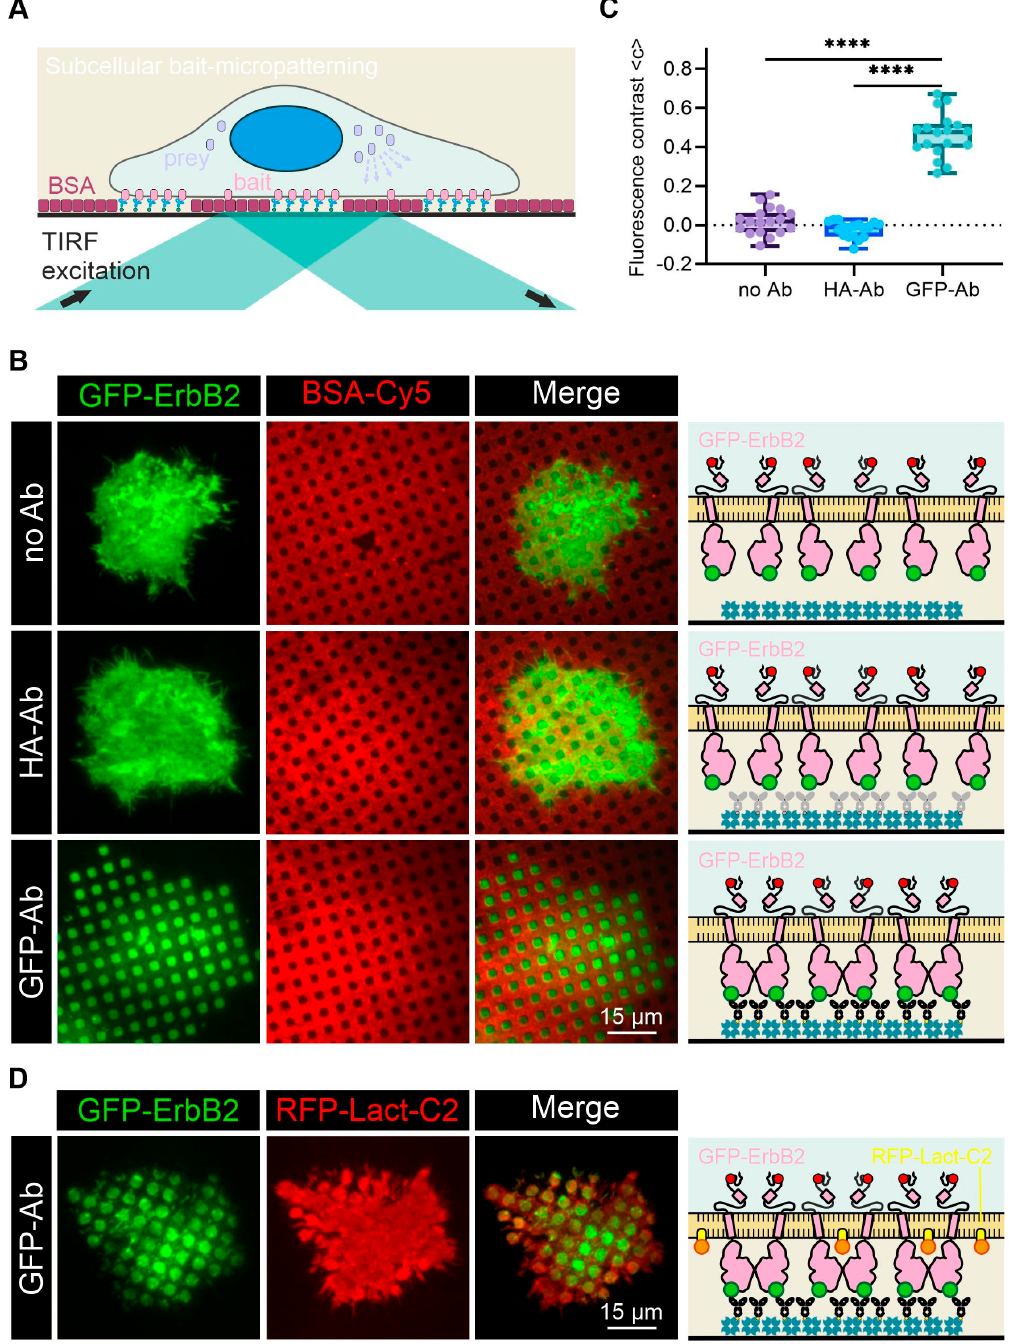
Figure 3. Applicability for subcellular micropatterning experiments. ( A ) Schematic presentation of the subcellular micropatterning assay. Cells are transiently cotransfected with fluorescently labeled bait (and prey) molecules and grown on antibody-patterned surfaces. Upon specific antibody–bait interactions, bait proteins are rearranged in the plasma membrane according to the surface pattern. ( B ) Representative TIRF microscopy images of GFP-ErbB2-expressing cells grown on BSA-Cy5-patterned surfaces consisting of: no antibodies (top), unspecific anti-HA antibodies (middle) and specific anti-GFP antibodies (bottom). ( C ) Box plots show quantitation of GFP contrast of cells grown under conditions as in ( B ) ( n = 18 cells; **** p < 0.0001 for comparison with GFP-Ab). ( D ) Representative TIRF microscopy images of cells coexpressing GFP-ErbB2 and RFP-Lact-C2 grown on anti-GFP antibody-patterned surfaces.